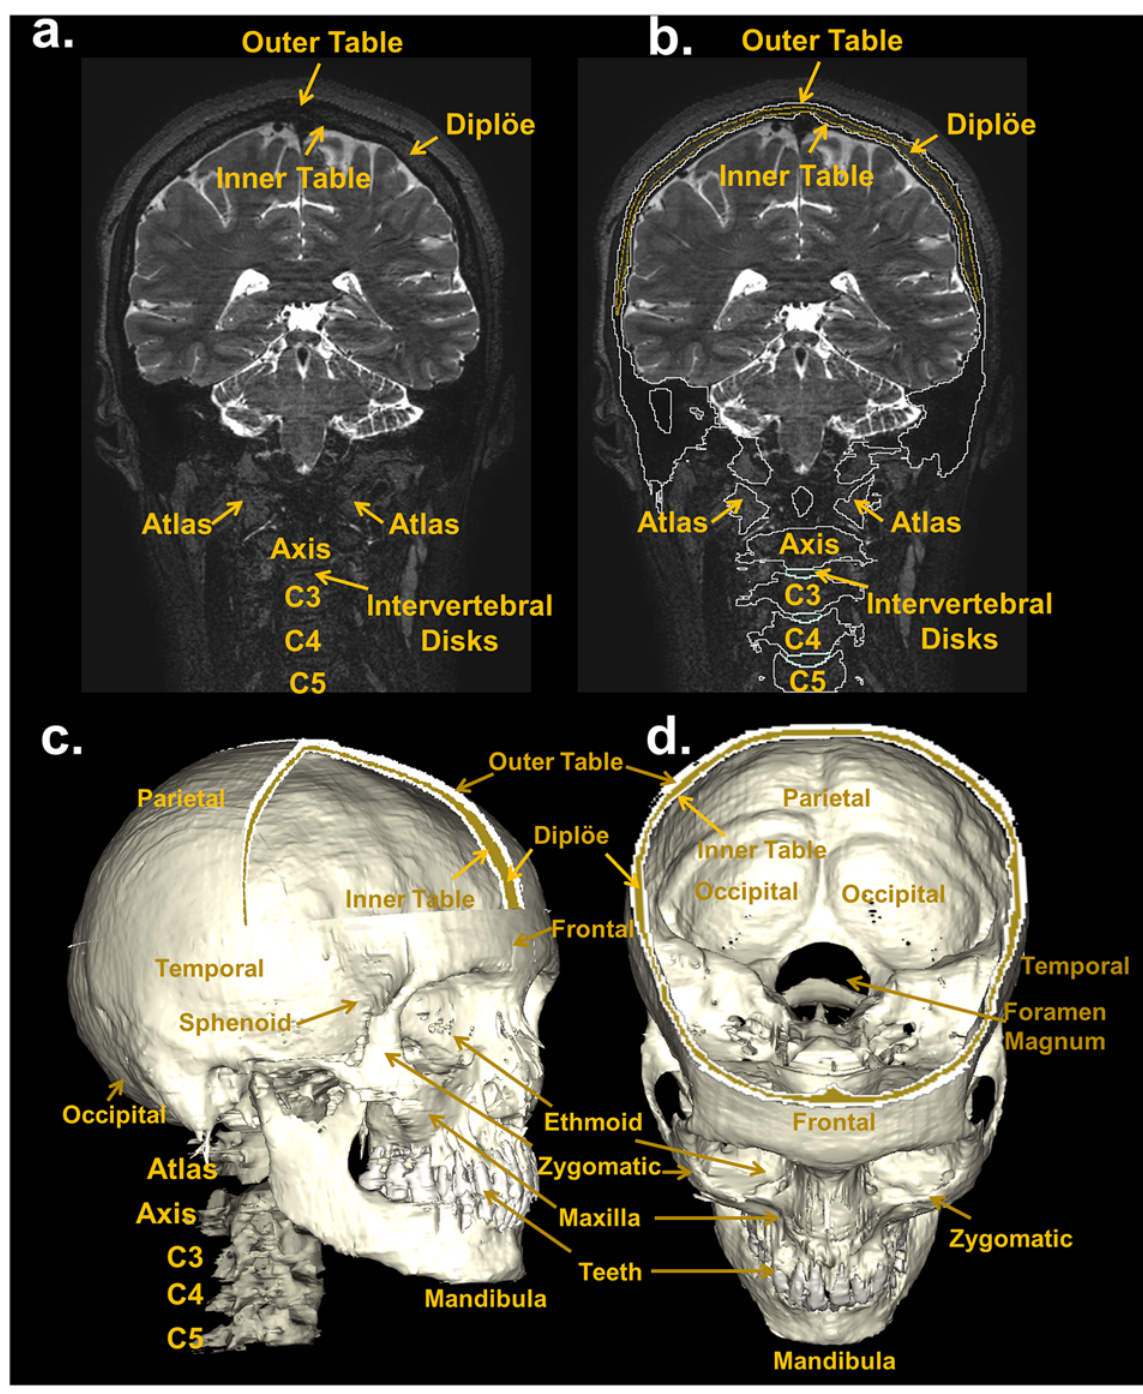
Fig 15. Segmentation of the bone. Top: coronal view of a T2-weighted MRI slice (a) with the skull, vertebrae, and intervertebral disks outlined (b). The T2-weighted MRI, in which the intensity of the cancellous bone inside the diploë is enhanced compared to that of the cortical bones of the inner and outer tables made the subdivision of the skull into the main three layers, i.e., outer table (white outline), diploë (yellow outline), and inner table (white outline) possible. Bottom: 3D reconstruction of the skull, vertebrae, and intervertebral disks (c and d).